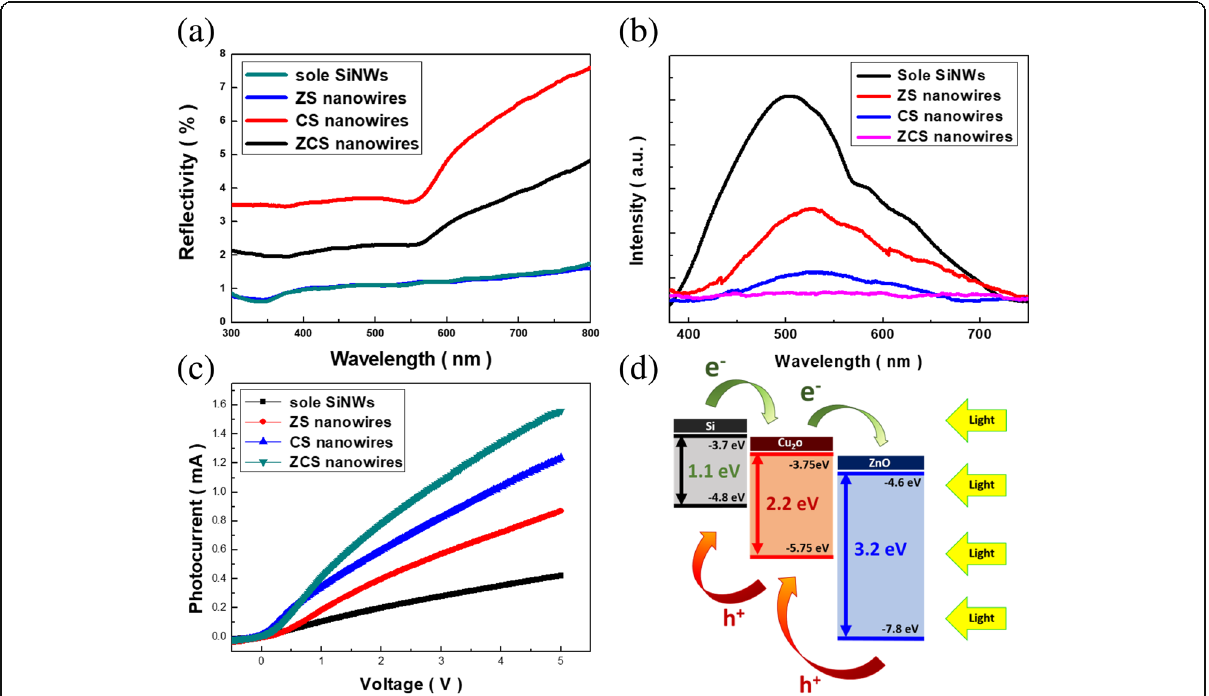
Fig. 3 a Light-reflectance spectra, b photoluminescence spectra, and c measured photocurrents under the 580-nm illuminations of varius samples. d The band diagram of ZCS